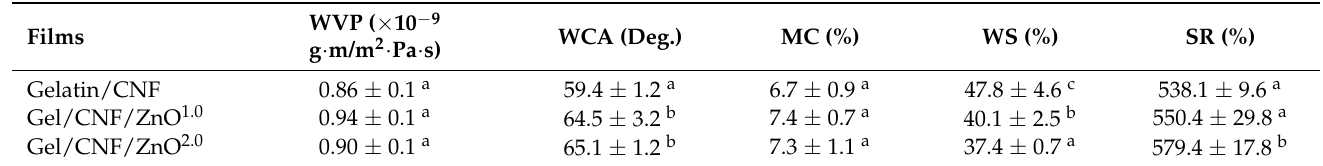
Table 3. Water vapor permeability, contact angle moisture content, water solubility, and swelling ratio of the gelatin/CNF-based